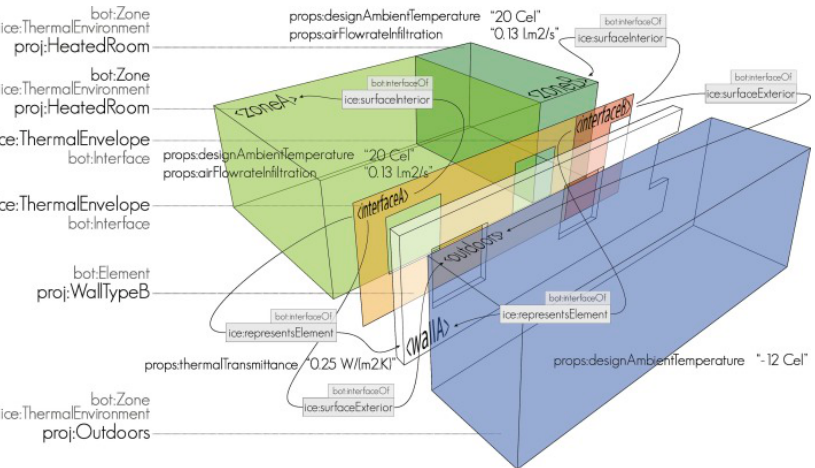
Figure 6. Visualization of the AEC ‐ KG model for the heat ‐ loss calculation case study [74] (Re ‐ printed from Elsevier Automation in Construction, Volume 108/December 2019, 102956, Mads Holten Rasmussen, Maxime Lefrançois, Pieter Pauwels, Christian Anker Hviida Jan Karlshøj, “Managing interrelated project information in AEC Knowledge Graphs”, Pages No. 4 and